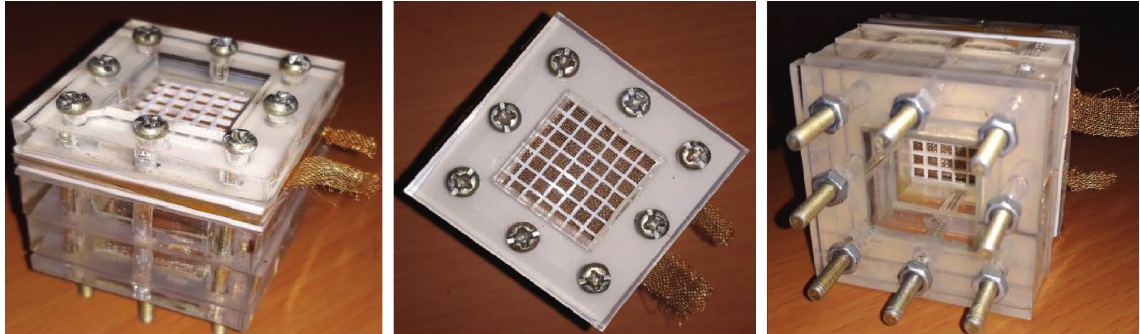
Figure 8: Schematic view of the fabricated methanol microfuel cell.